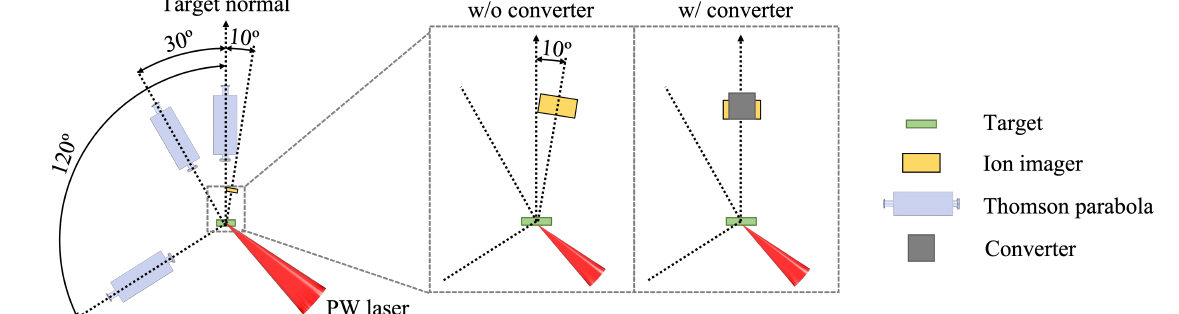
Figure 2. Ion beam diagnostics, three Thomson parabolas and an ion imager, placed around the converter during neutron generation, are set up at various angles from the target normal